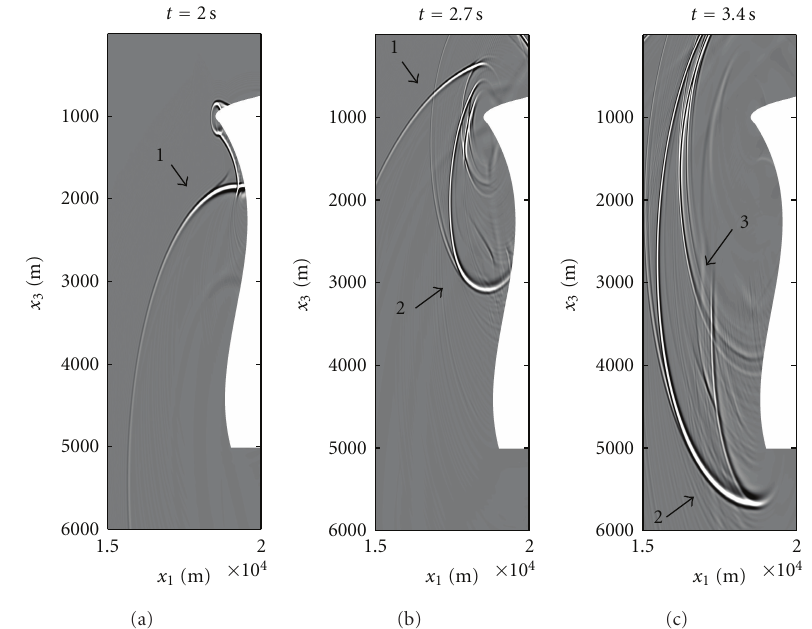
Figure 20: Snapshots at 2.0 s, 2.7 s and 3.4s of the wavefield emitted by a source at x A = (15000m,4000m); reflections 1, 2, and 3 are indicated.